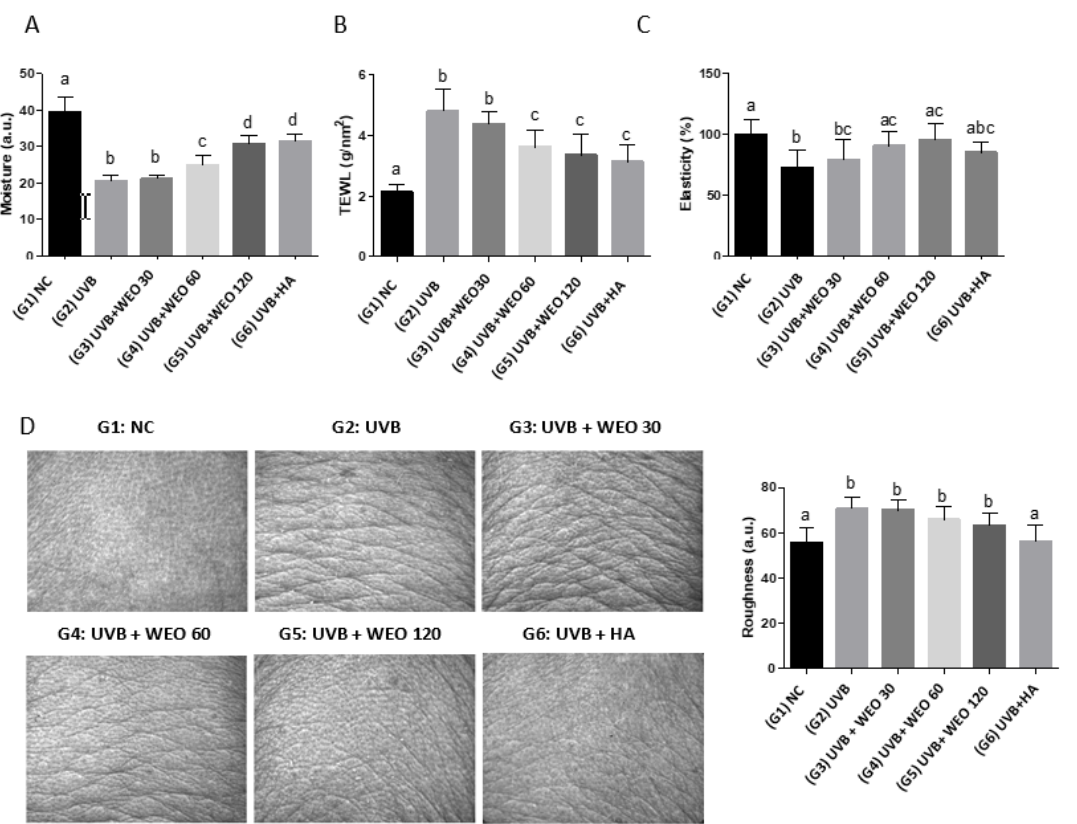
Figure 1. WEO-induced changes in skin surface condition at week 12. ( A ) Skin moisture measurement by Corneometer CM825. ( B ) Transepidermal water loss measurement by Tewameter TM 300. ( C ) Skin elasticity measurement by Cutometer MPA580. ( D ) Roughness measurement by Visioscan VC98. Values with different letters are significantly different by analysis of variance (ANOVA) followed by the Newman– Keuls multiple range test ( p < 0.05). NC: normal control, UVB: Ultraviolet, WEO: wheat extract oil, HA: Hyaluronic acid.